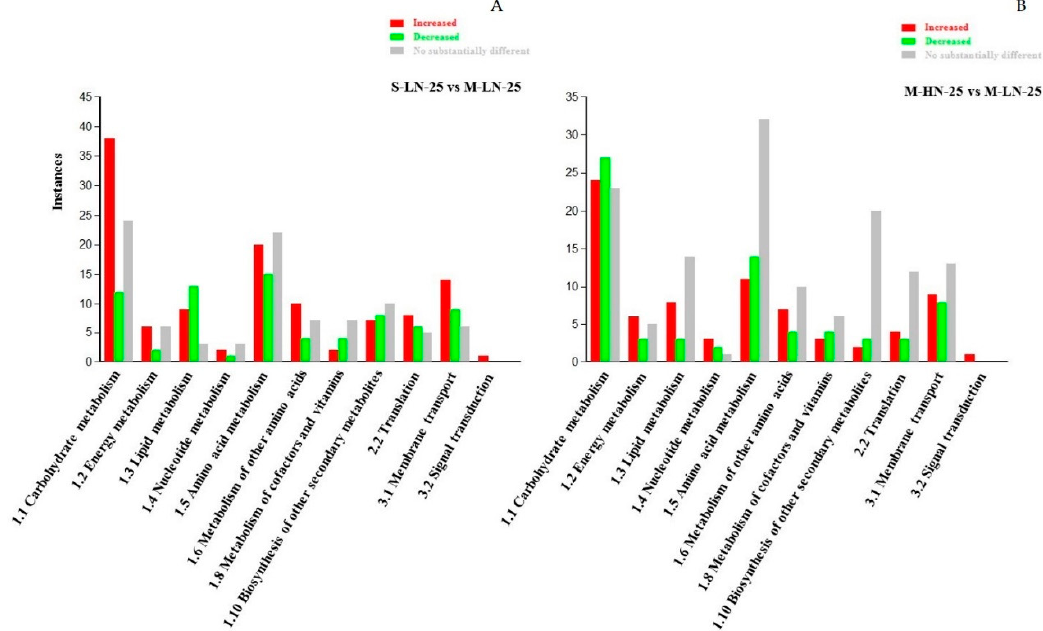
Figure 4. Fluctuations of the stamnagathi metabolic functions following treatments with total-N concentration (4 or 16 mmol L − 1 , denoted as Low-N and High-N, respectively) upon different seed origin (montane vs. seaside) of stamnagathi plants grown under a total-N concentration of 4 mmol L − 1 ( A ) and in the nutrient solution supplied to the montane ecotype of stamnagathi grown in perlite bags ( B ). The y -axis corresponds to instances, since each metabolite can be involved in multiple pathways. The first bar (red) corresponds to metabolites whose concentration increased in response to the treatment, the second (green) to those decreased, and the third (gray) to those that were not substantially altered. The coding system of KEGG (Kyoto Encyclopedia of Genes and Genomes) as adopted.